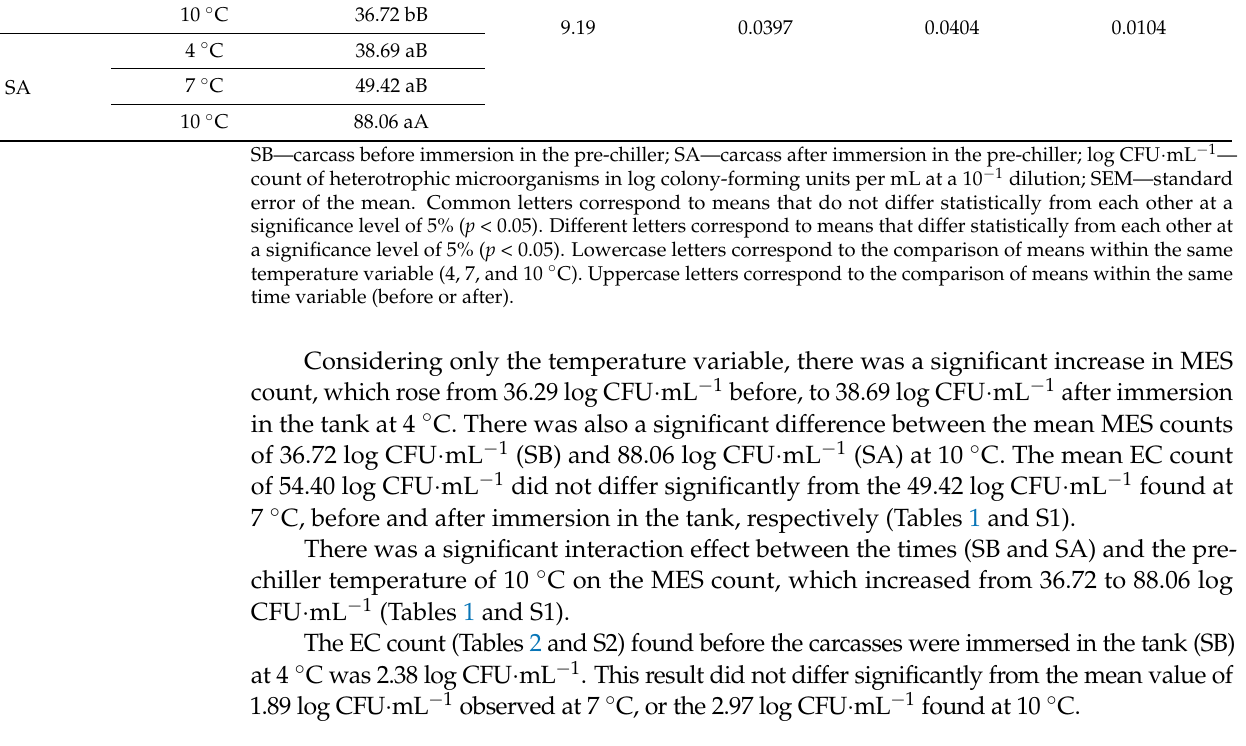
Table 2. Effects of immersion of rabbit carcasses in the pre-chiller, water temperature, and their interaction on the mean count of enterobacteria